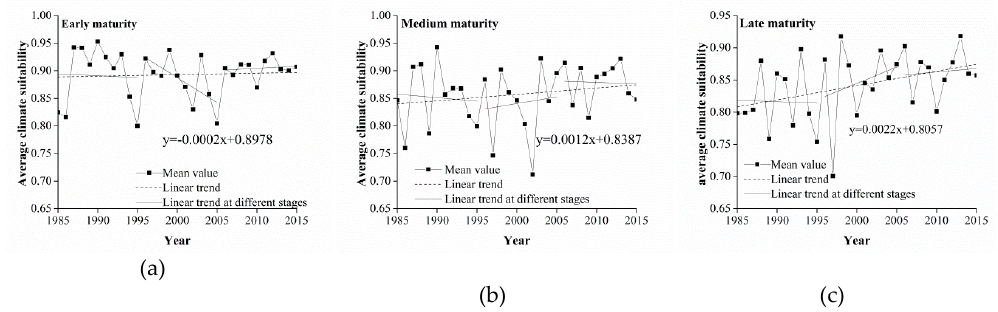
Figure 6. Comparison of scaled station mean meteorological yield and station mean suitability (calibration stations: gray dot; validation stations: red triangle; d < 0.6: blue circle; dotted line indicates 1:1 relationship).